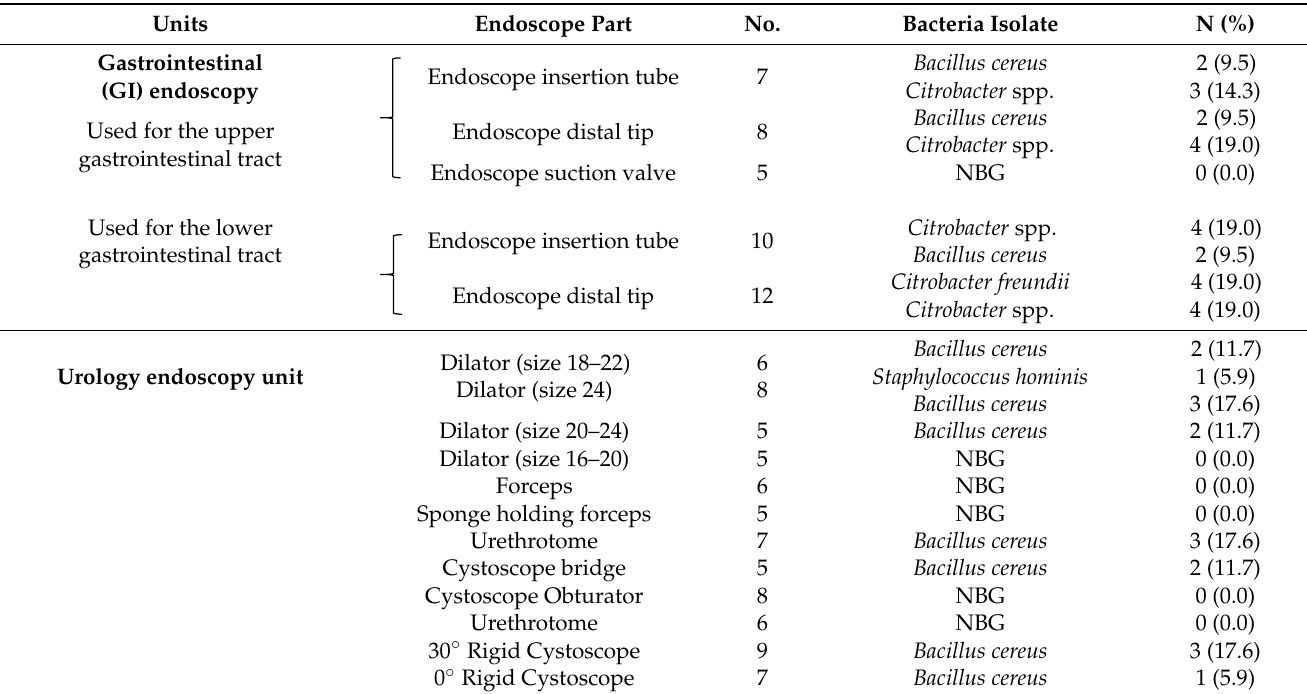
Table 2. Bacteria isolated from the disinfected endoscopes parts used at the gastrointestinal (GI) endoscopy and urology endoscopy (uro-endoscopy) units.